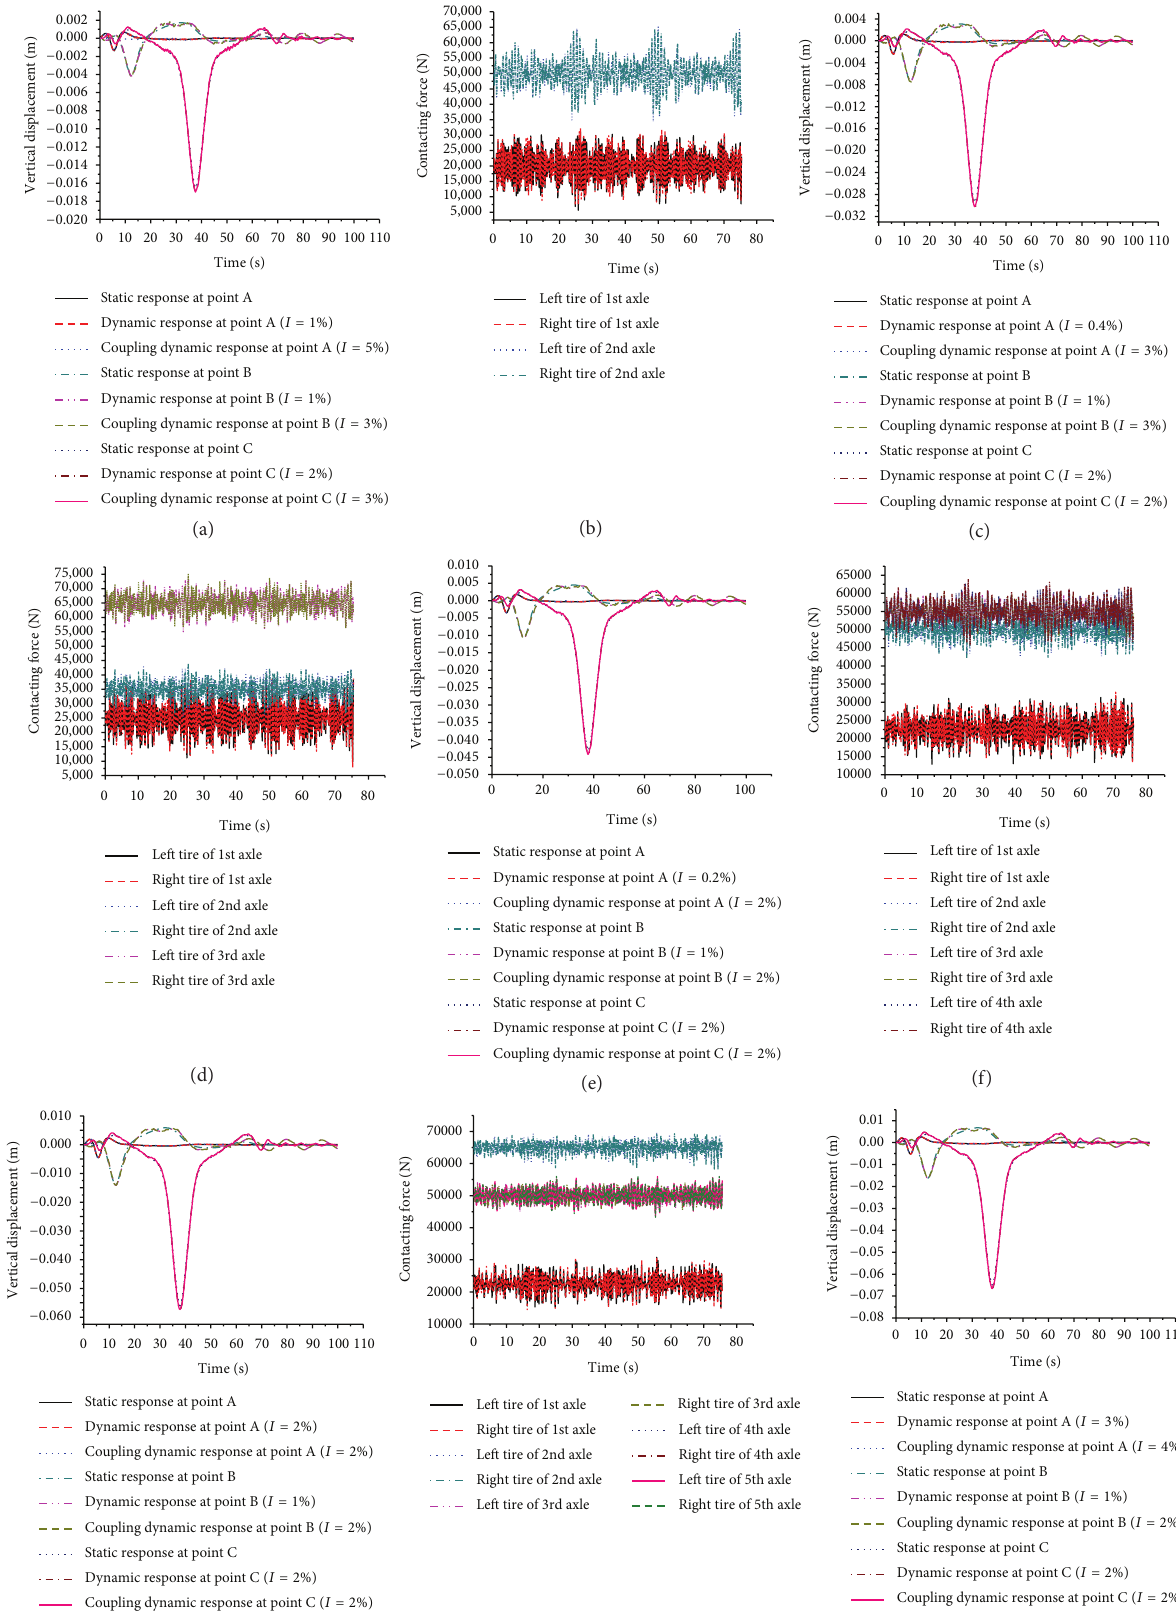
Dynamic response at point C (I =